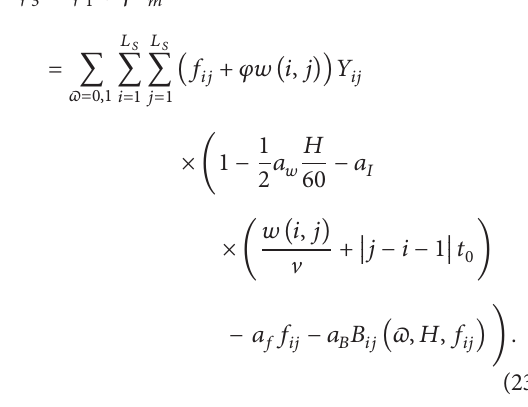
Algorithm 1. Generation algorithm of the feasible